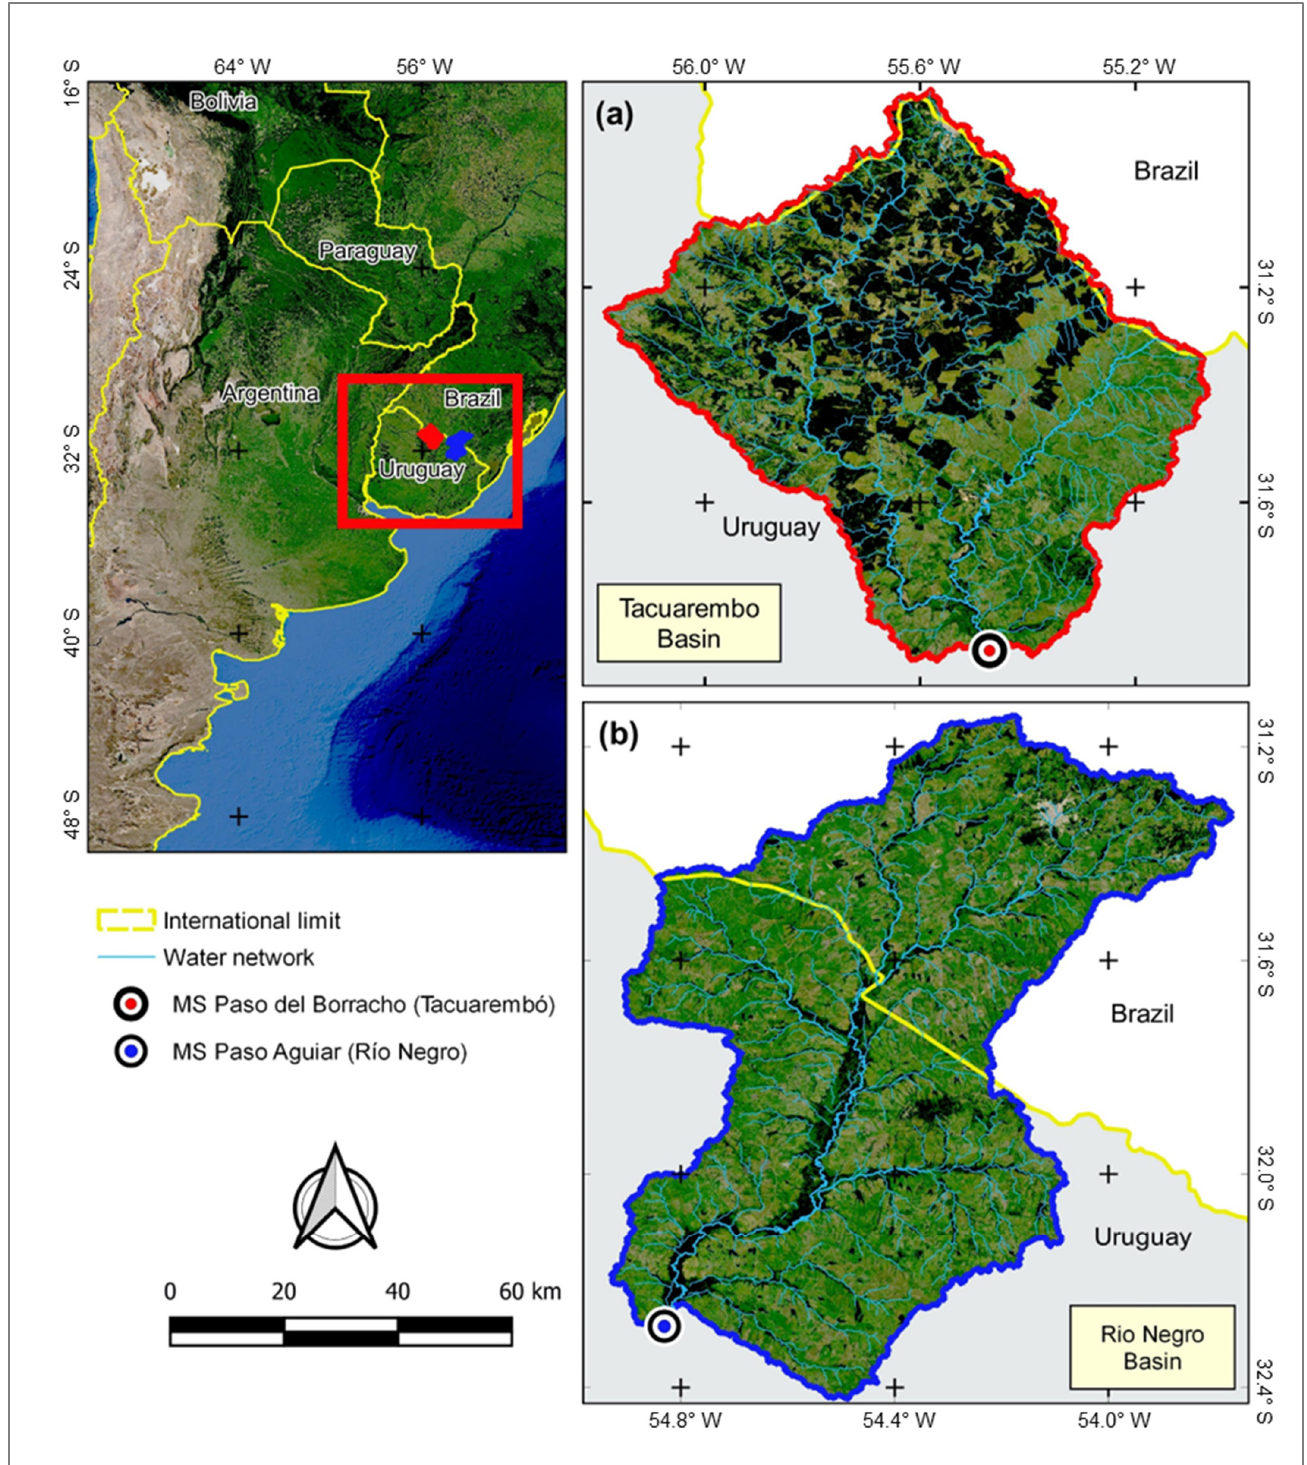
Figure 1. Location of the study area and base flow monitoring stations. ( a ) The red line and polygon correspond to the delimitation of the Tacuarembó River Upper Basin. ( b ) The blue line and polygon correspond to the delimitation of the Upper Río Negro Basin. The Base Flow Monitoring Stations (MS) are represented by the red dot (Paso del Borracho—Upper Tacuarembó River Basin) and the blue dot (Paso Aguiar—Upper Negro River Basin). The red box encloses the exact location of both basins in South America. The yellow lines correspond to the international limits.